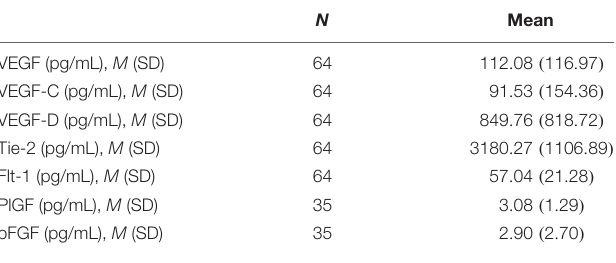
was observed, with APOE4 carriers having greater SVD burden [ N = 48; β = 0.57, 95% CI (0.01, 1.13), p = 0.046; Table 3